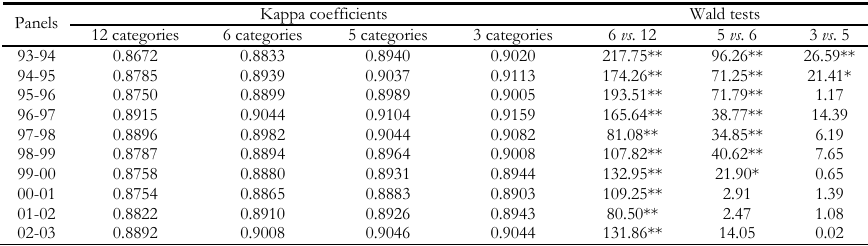
Hierarchical Kappa coefficients and Wald tests: industry